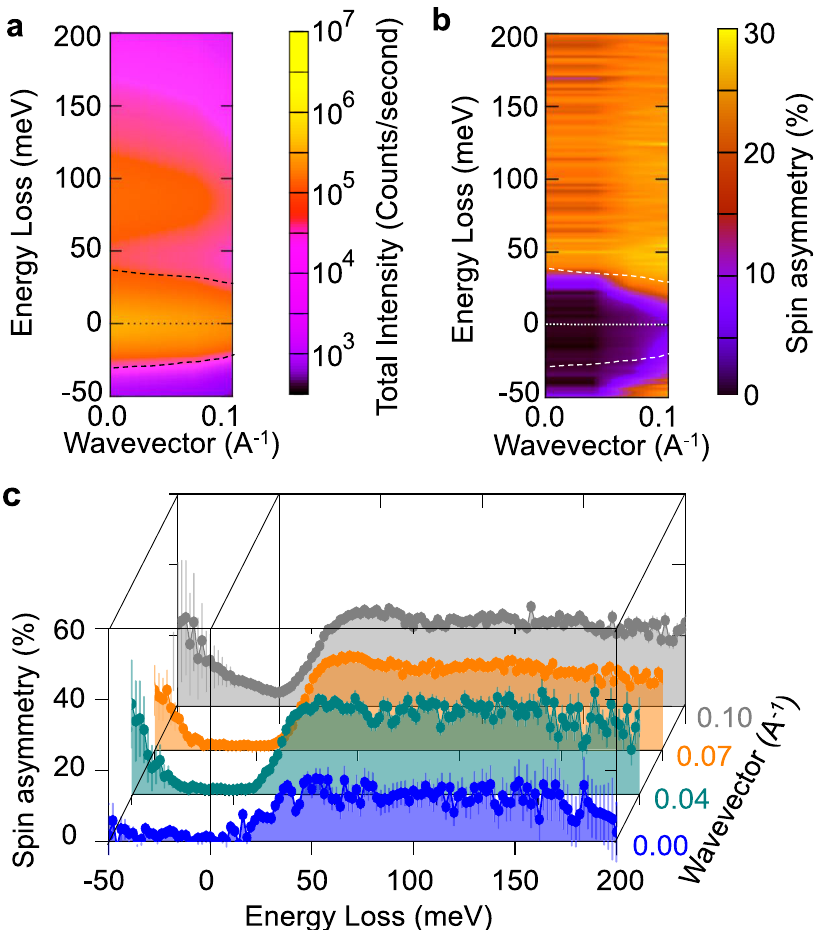
-- Γ -point. a The total intensity of the scattered electrons in the energy loss – momentum Fig. 3 Spin asymmetry maps in the vicinity of the high symmetry space. The high intensity at around 90 meV indicates the presence of the collective charge excitations. b The spin asymmetry ( A ¼ I # (cid:2) I " I ) maps in the # þ I " energy loss – momentum space. c The representative examples of spin asymmetry spectra shown in b . In all the fi gures, the area marked by the dashed lines is the region of the (quasi)elastic scattering. The data are recorded at an incident electron energy of E i = 4.0 eV. The error bars represent the statistical